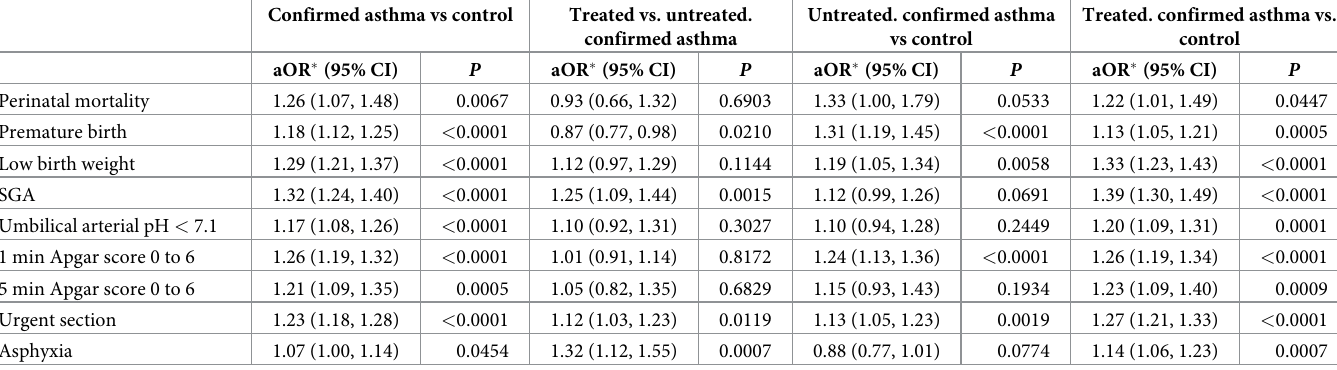
Table 2. Perinatal outcomes in mothers with confirmed, treated or untreated asthma for singleton live and stillbirths. Confirmed asthma vs control Treated vs. untreated. Untreated. confirmed asthma Treated. confirmed asthma vs. confirmed asthma vs control